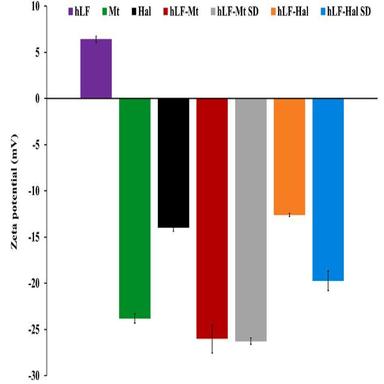
Values of ζ-potential of nanohybrids and pristine components in distilled water and 25 ◦C (mean values ± s.d.; n = 3).